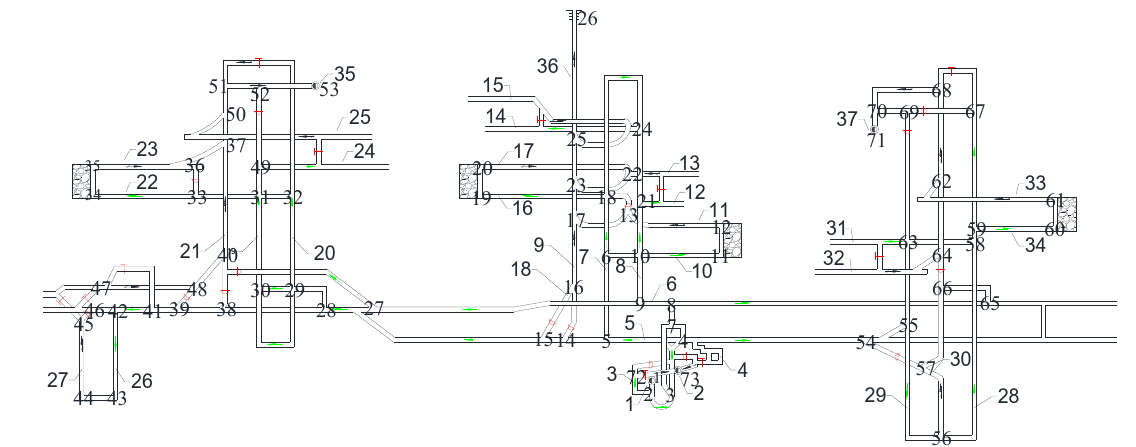
Figure 7. A coal mine ventilation system used by Jinmei Co., Ltd. (Red indicates the position of air doors or wind windows, and black arrows indicate the exhaust air flow. Green is the incoming air flow as well as the fresh air flow. Each number indicates the junction number and tunnel number). Table 4. Ventilation system of Jinmei coal